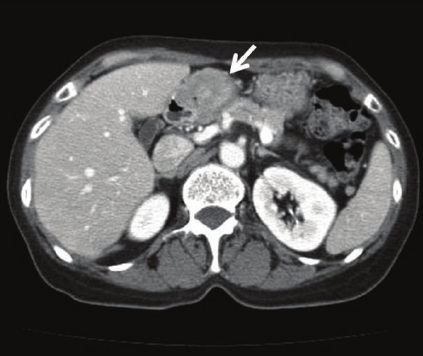
Figure 2: Computed tomography showed a tumor located at the antrum of the stomach (arrow), with no invasion of the primary tumor to adjacent structures and no distant